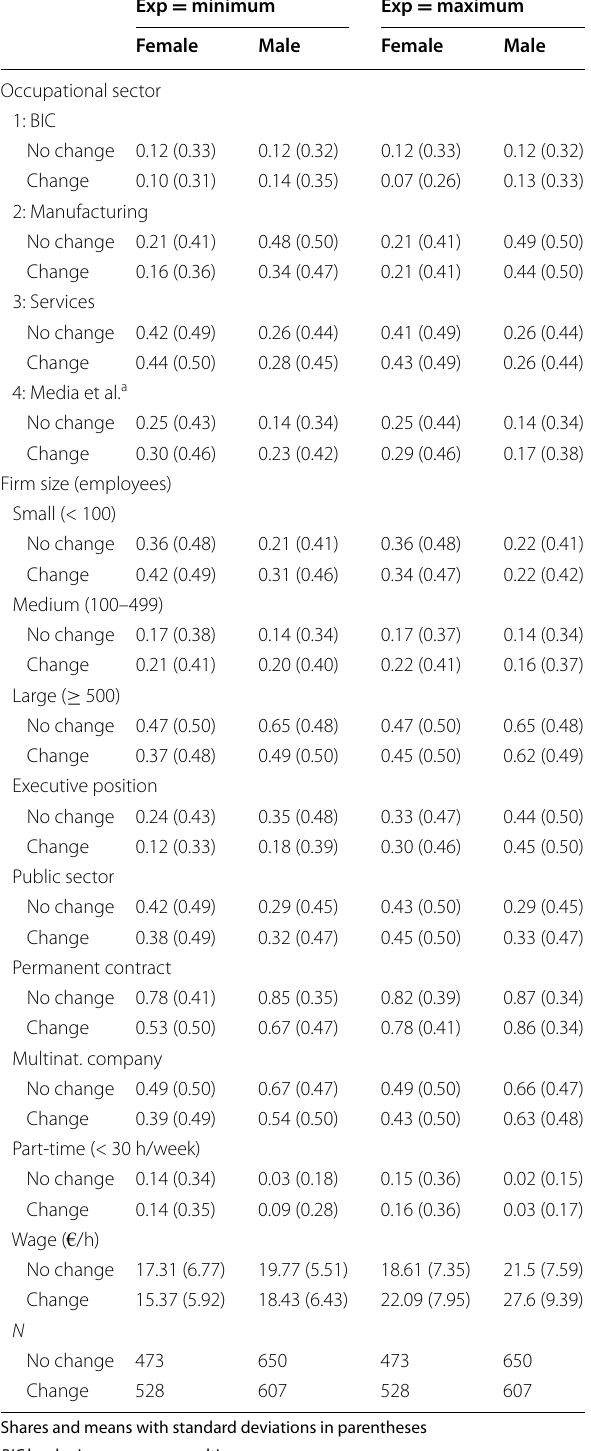
Table 3 Time-variant sample characteristics by gen- der, employer change and work experience. Source